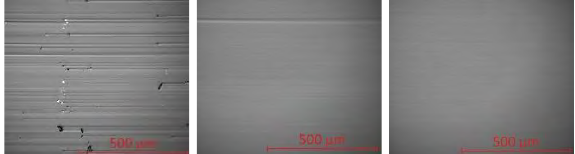
Fig . 9 . Microscopic view in depths 12 µm, 24 µm and 36 µm respectively of the V-shape polished surface grinded with the D91